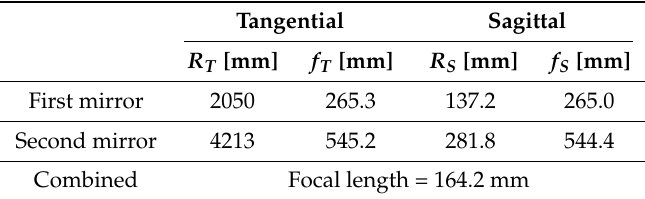
Table 1. Radii of curvature (provided by the manufacturer), focal lengths of the individual mirrors in the two planes, and the equivalent focal length of the